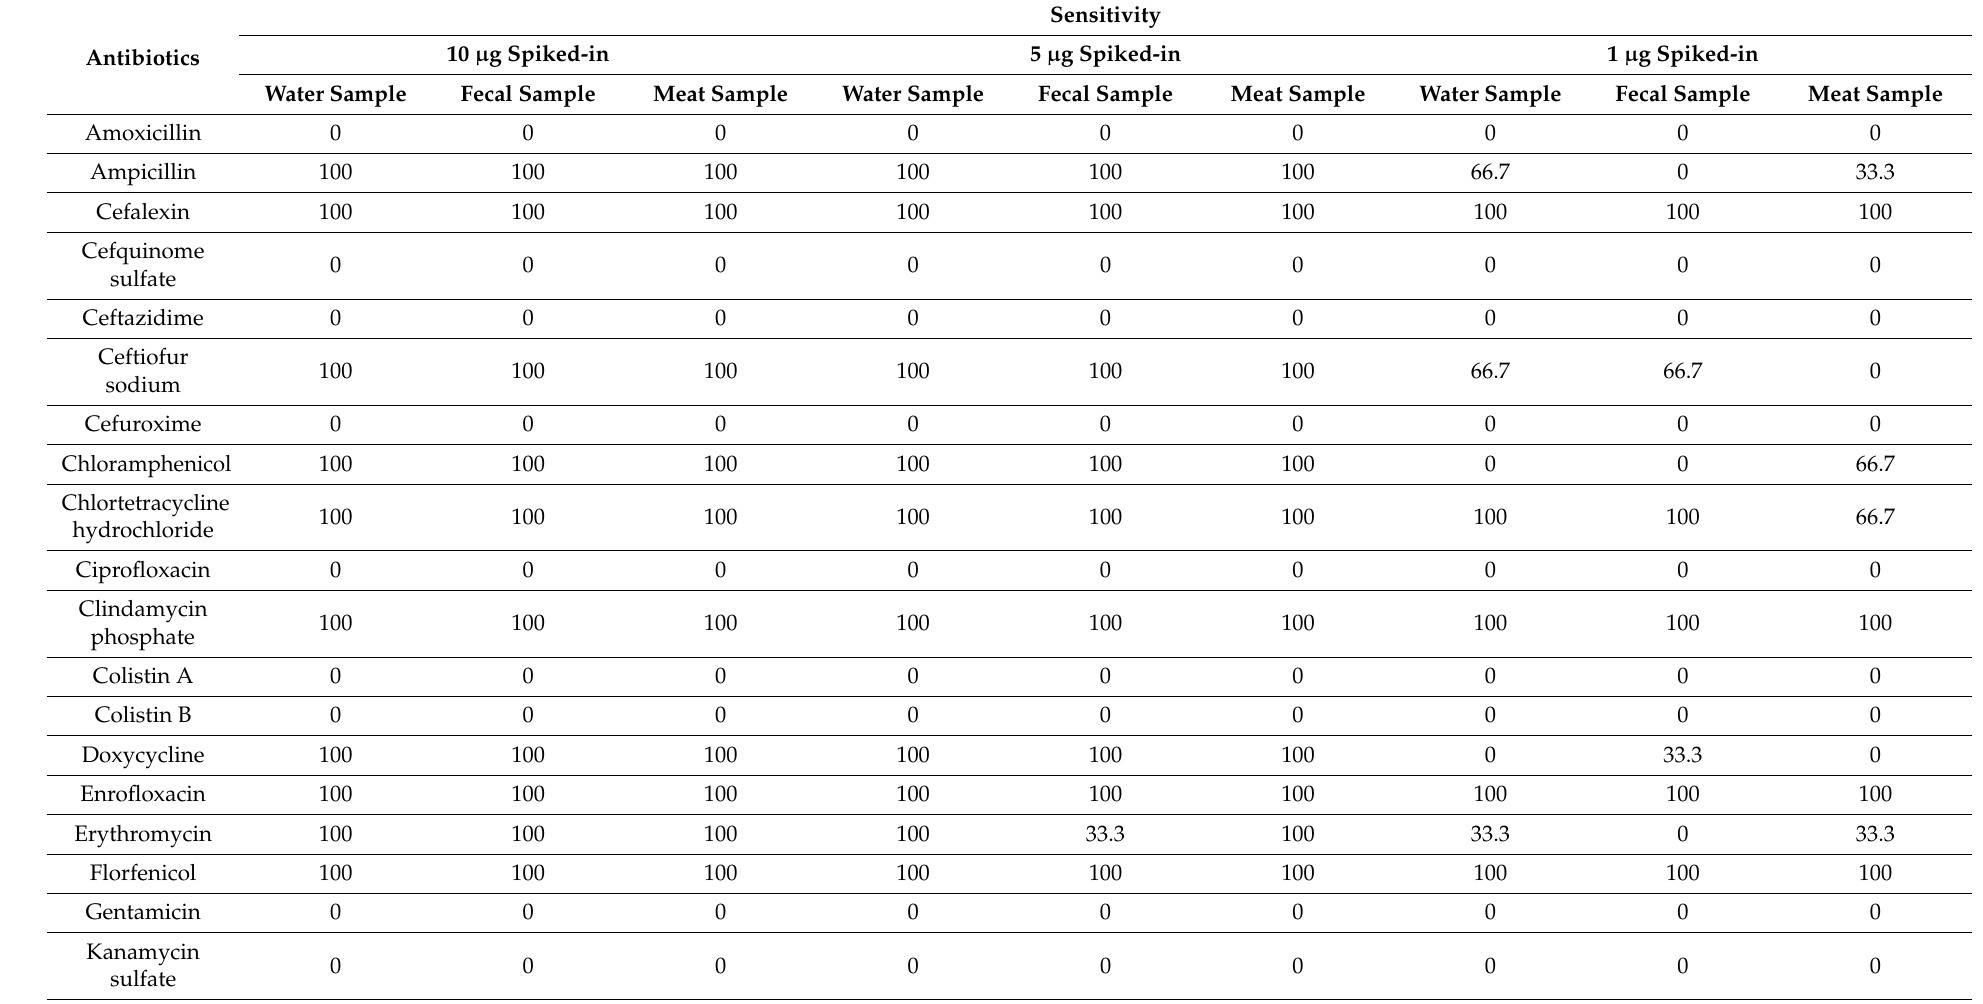
Table 5. Sensitivity of overall protocol for 43 antibiotics at spike-in concentrations of 10 µ g, 5 µ g, and 1 µ